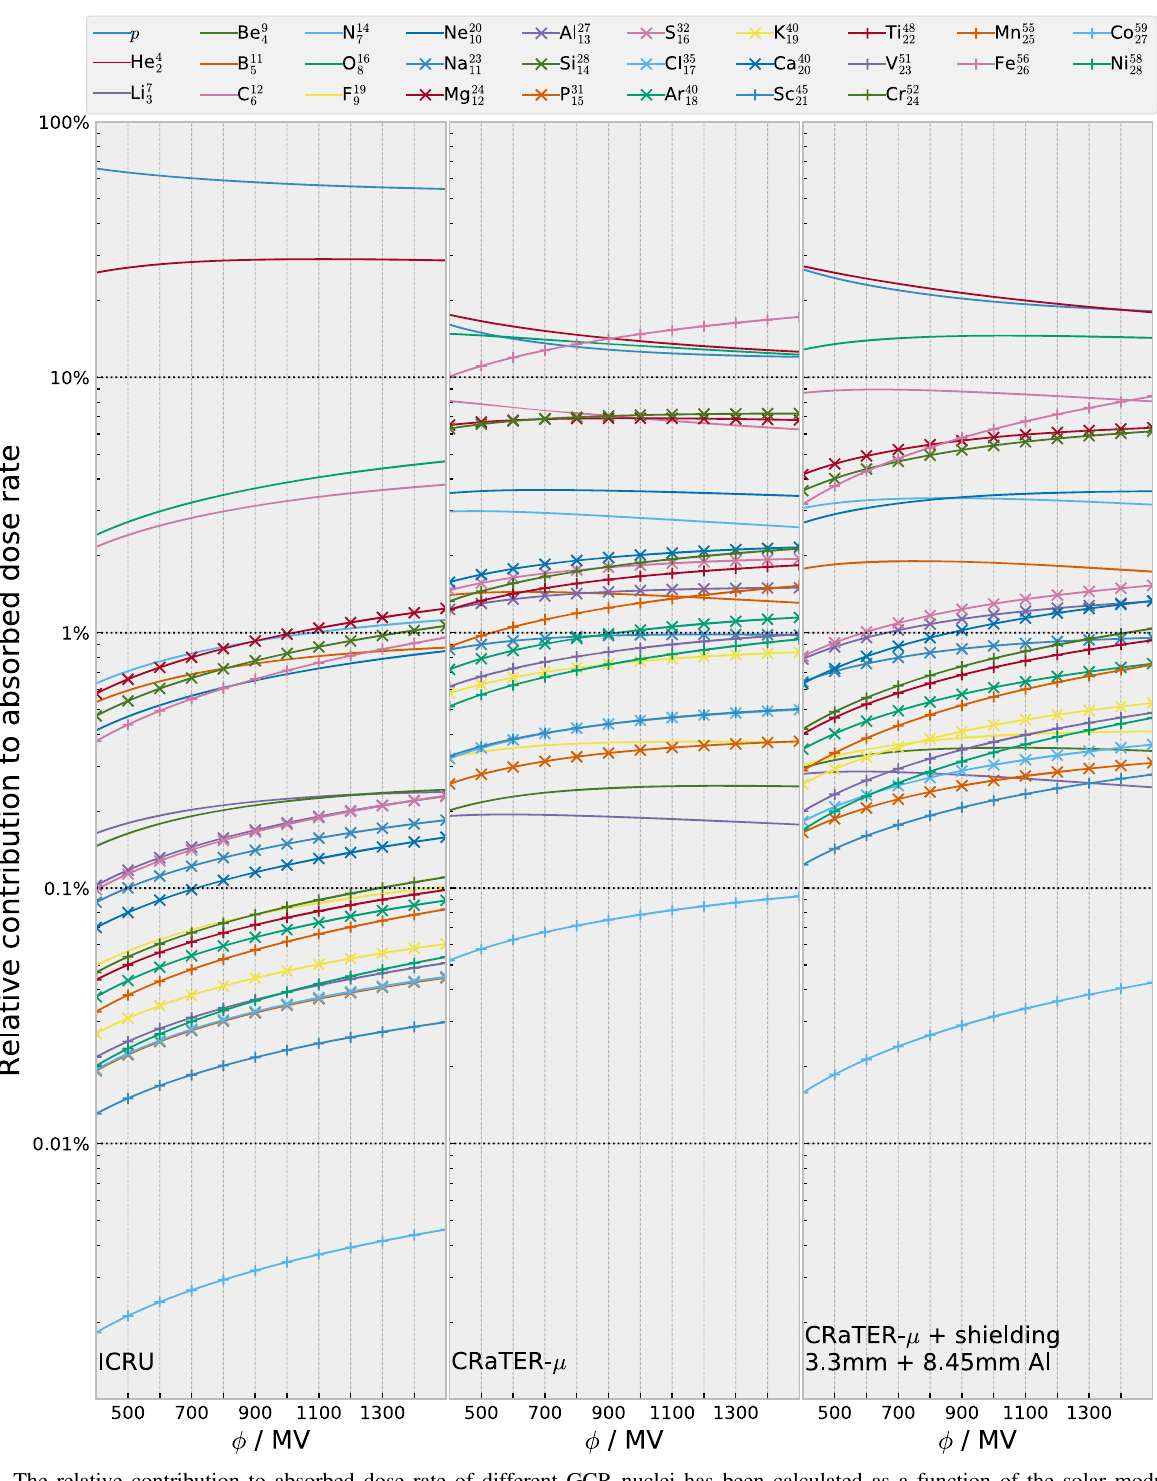
Fig. 6. The relative contribution to absorbed dose rate of different GCR nuclei has been calculated as a function of the solar modulation parameter / , that is shown on the x -axis. The different GCR nuclei are indicated using different line markers and colors (see legend). For the ICRU phantom, the most contributing GCR species are protons, followed by helium, oxygen and carbon nuclei. The contribution of Z > 1 GCR species increases with / at the cost of the proton contribution. The CRaTER- l detector experiences a signi fi cantly higher contribution due to Z > 2 GCR nuclei, however, with shielding, this effect is somewhat